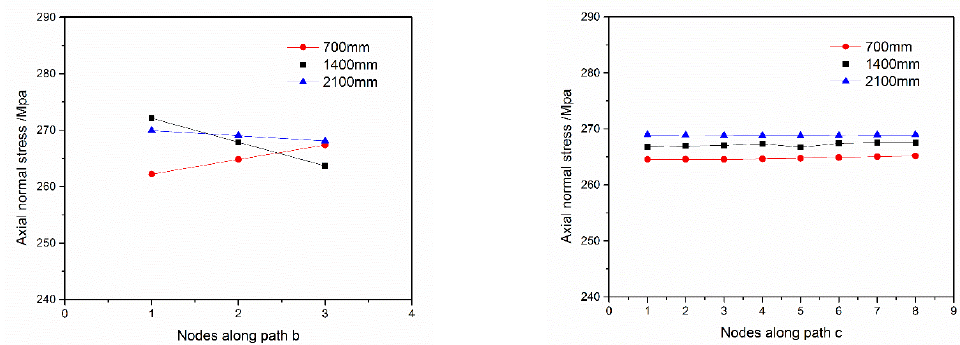
Figure 10. The axial normal stress distribution of nodes along path b and path c.